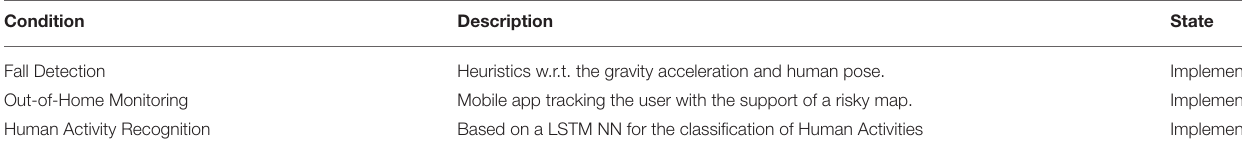
TABLE 3 | Approaches integrated in ATTICUS for the detection of inertial- and geographical-related anomalies.